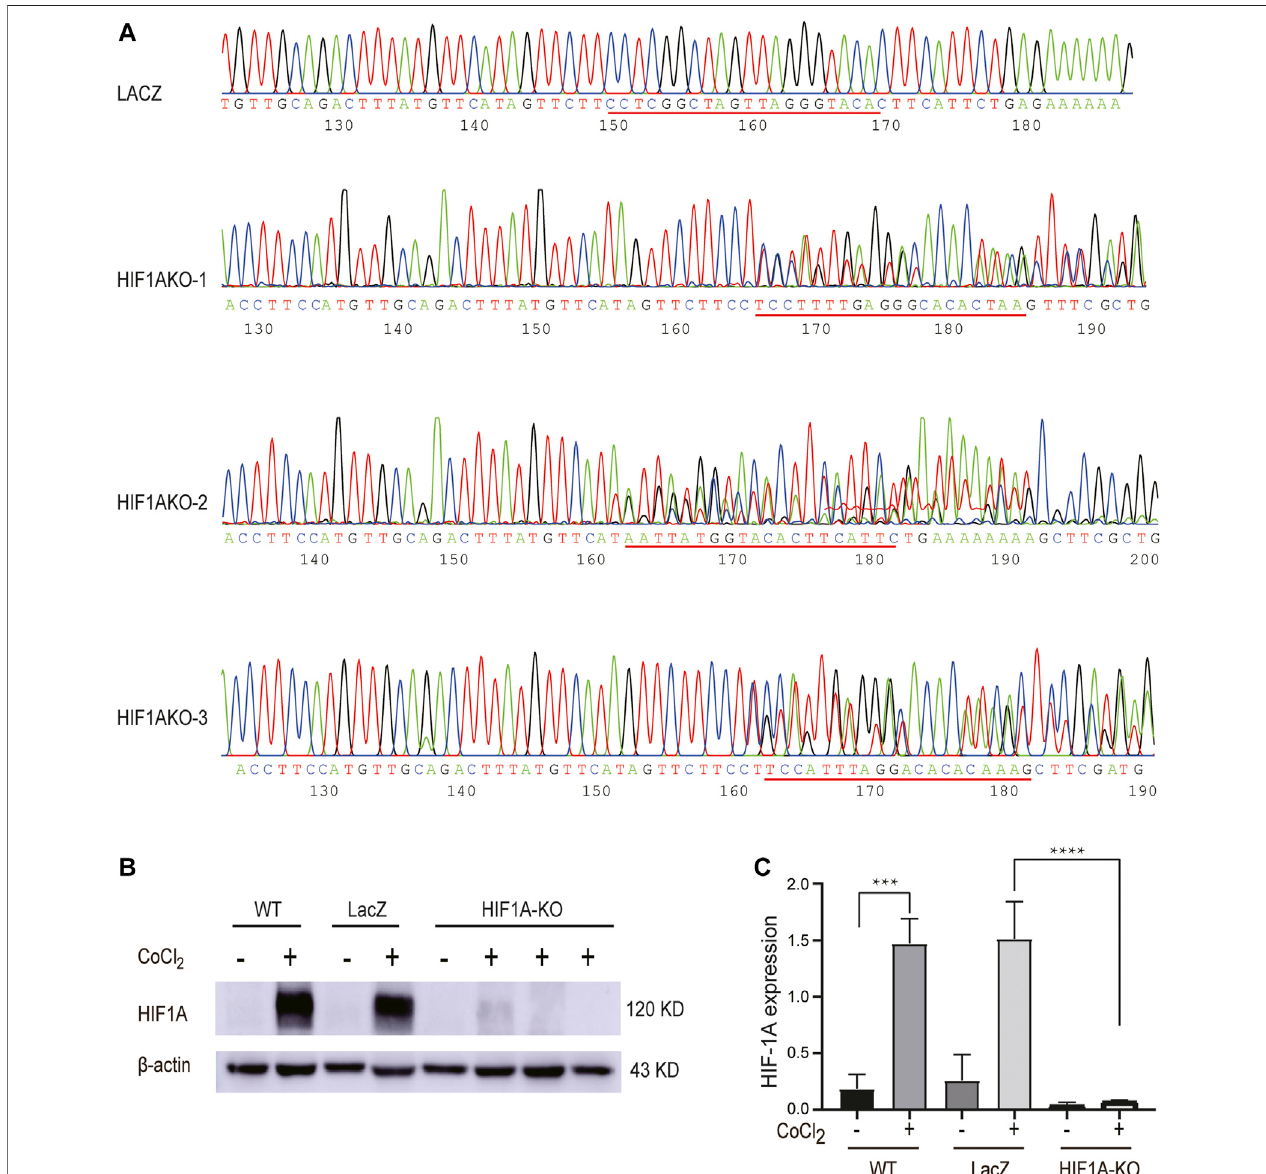
FIGURE 2 | Establishment of HIF1A -KO and LACZ -control HepG2 cells. (A) Stable expression cell lines of 52961V2-HIF1A and 52961V2-LacZ were sequenced. (B) Examination of HIF1A protein expression in control cells and HIF1A-KO cells byWestern blot. (C) HIF1A expression wassigni fi cantly reduced in the HIF1A knockout